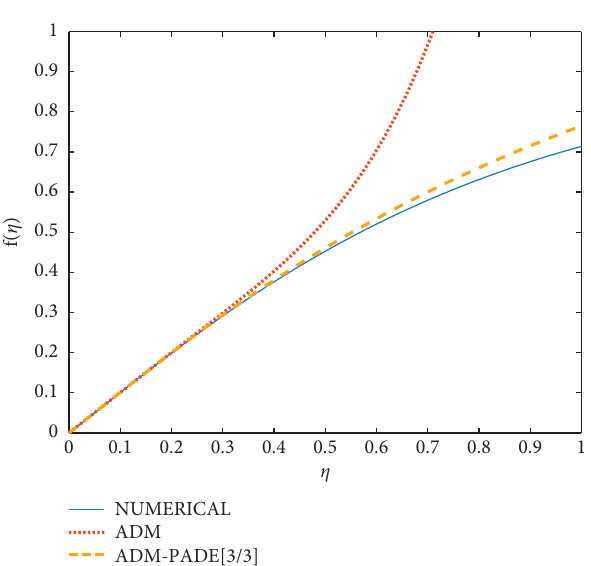
Figure 3: Comparative plot of stream function.